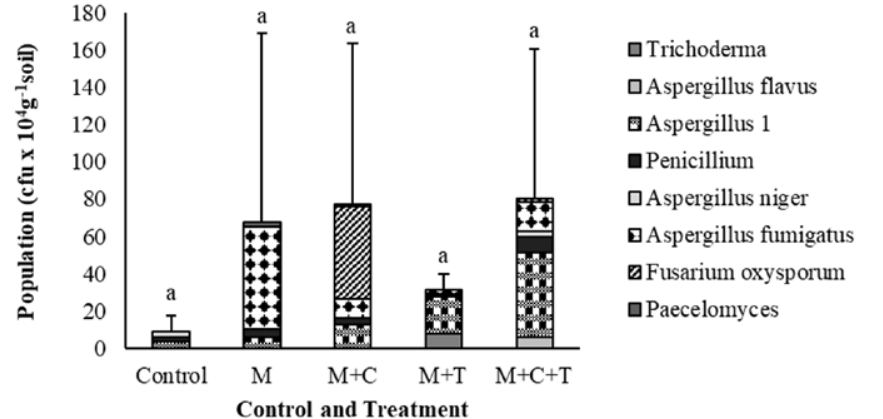
Fig. 3. Fungal population in soil assessed at harvesting time, 63 days after treatment by mulch, mulch plus compost, mulch plus Trichoderma asperellum , and mulch plus compost plus T. asperellum . M = mulch, C = compost, T = T. asperellum . Means of population at the same time, followed by the same letter are not significantly different according to DMRT (p ≤ 0.05). Vertical bars show standard errors of